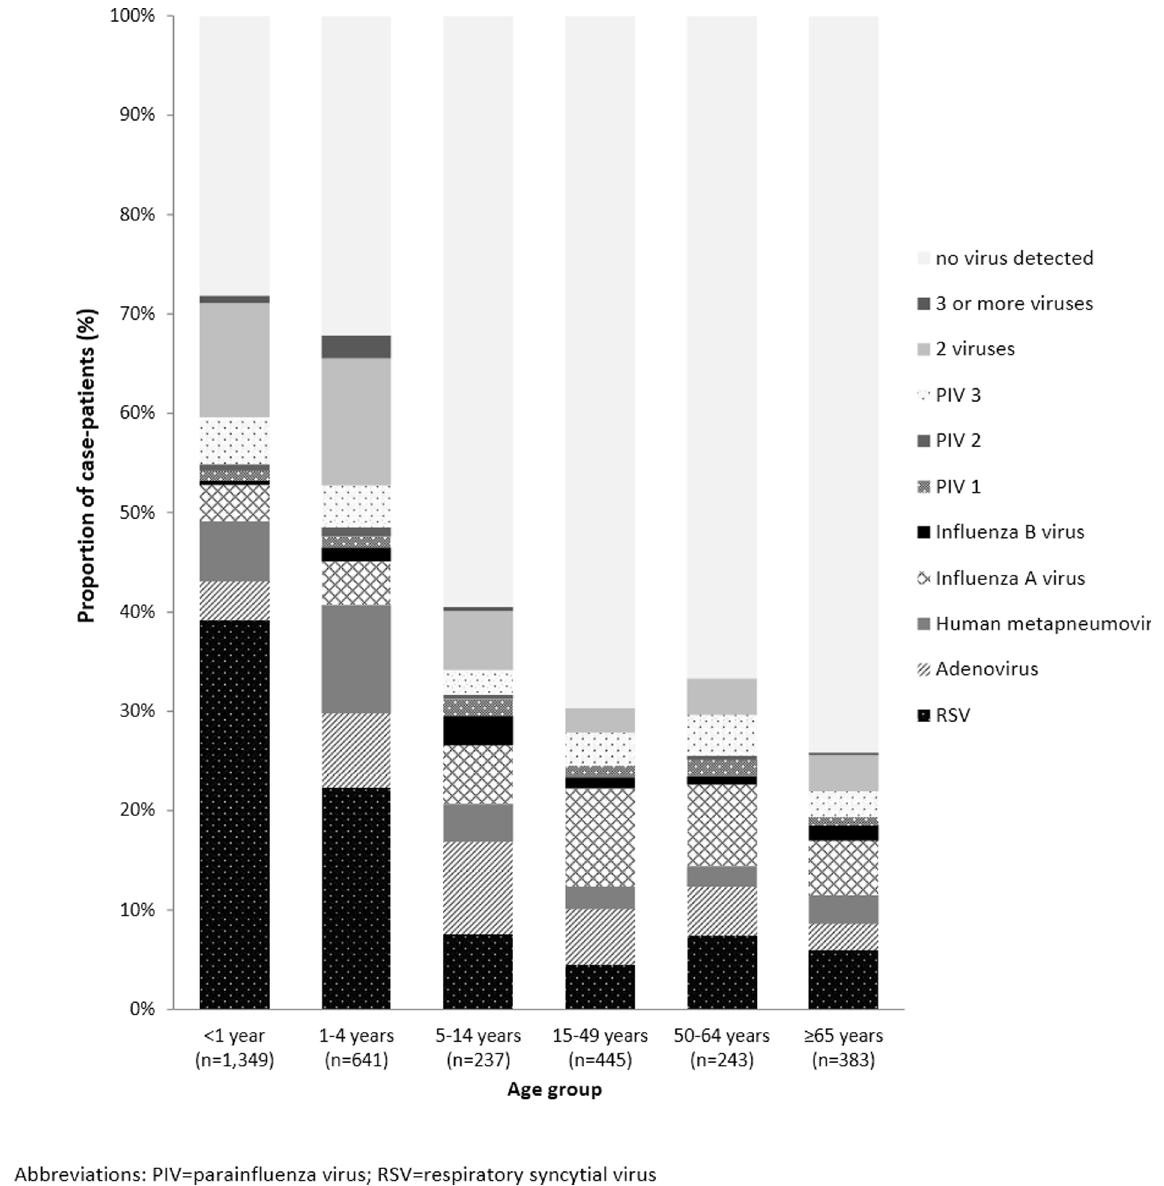
Figure 1. Viral pathogens by age group. Proportion of case-patients with viruses detected on nasopharyngeal/oropharyngeal swab, by age group.